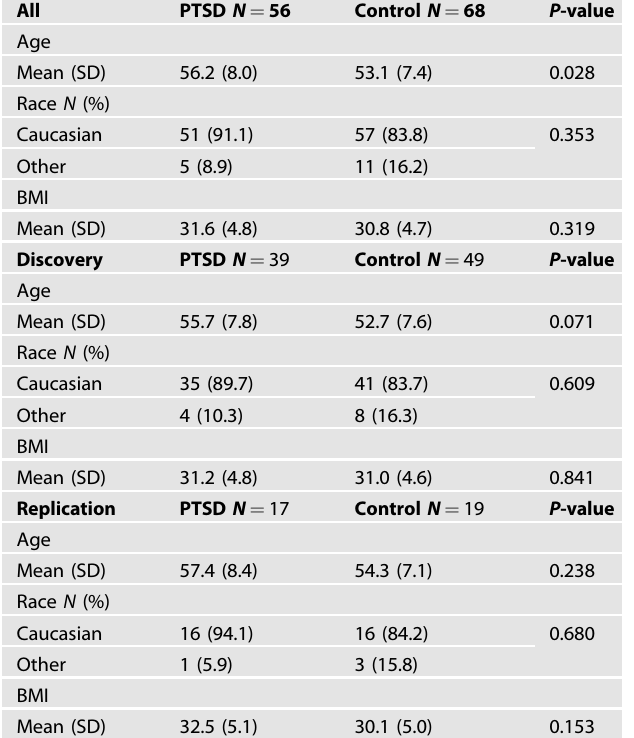
Table 1. Clinical characteristics of samples in discovery and replication subsamples. The p -values were computed from t-tests (for age and BMI) and chi-squared test (for race).